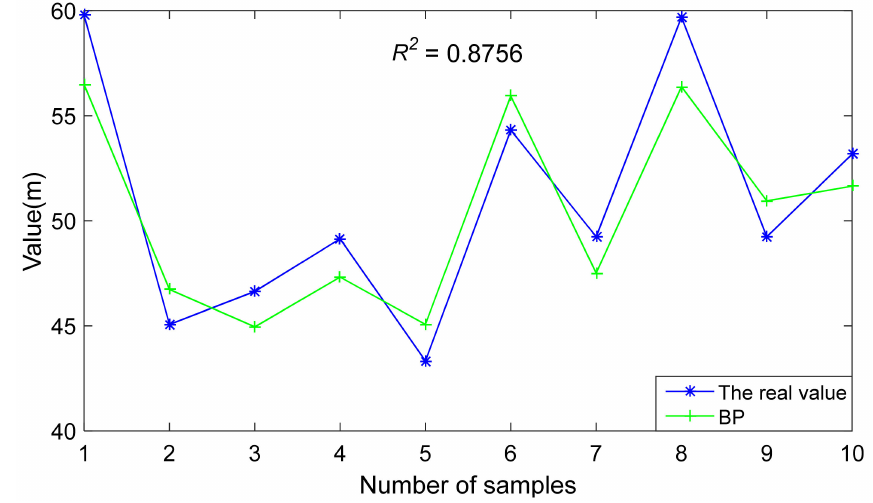
Figure 4. Comparison of the first roof weighting